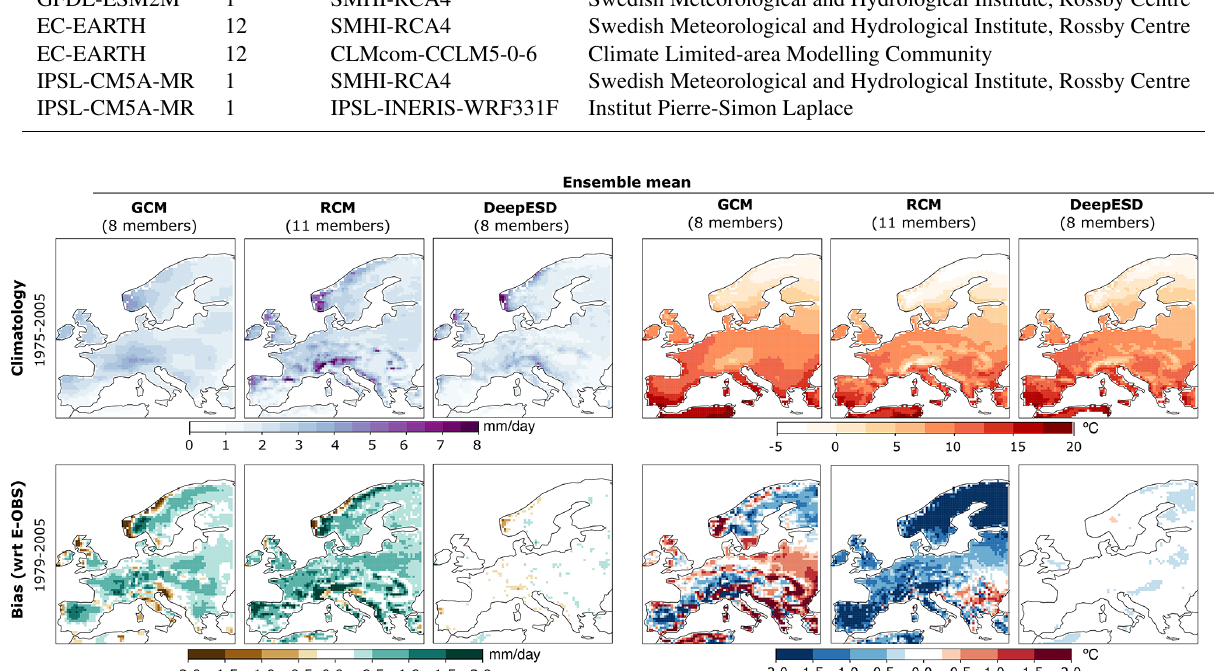
Figure 2. Annual daily precipitation (left block) and temperature (right) for the historical period 1975–2005, as obtained from the ensembles of GCMs, RCMs and DeepESD GCM-downscaled results (left, middle and right columns, respectively). The first row shows the ensemble mean climatological values, and the second row displays the corresponding biases with respect to E-OBS v20.